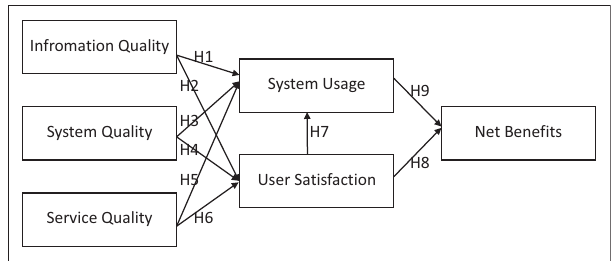
FIGURE 1: Research